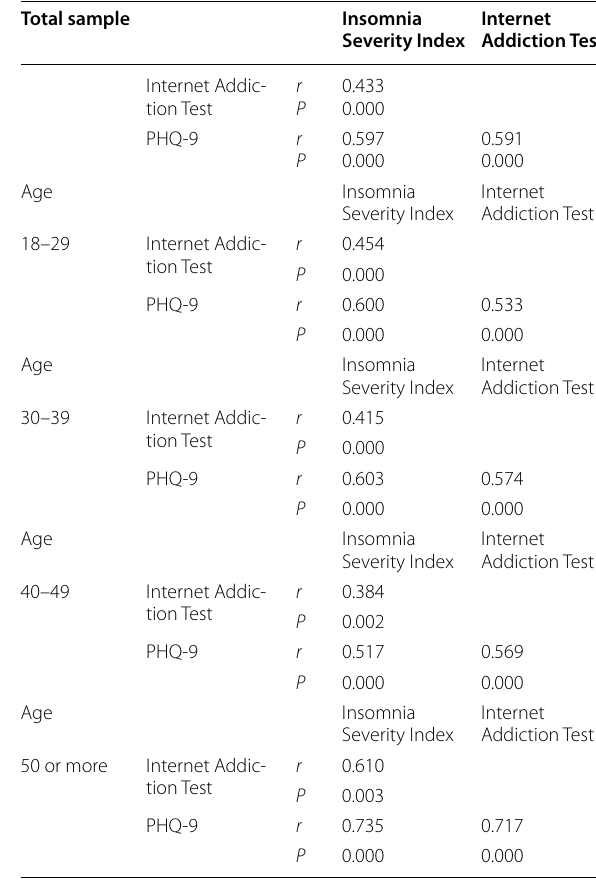
Table 7 Correlation between the three indices (ISI, IAT, and PHQ9) within the total sample and each age